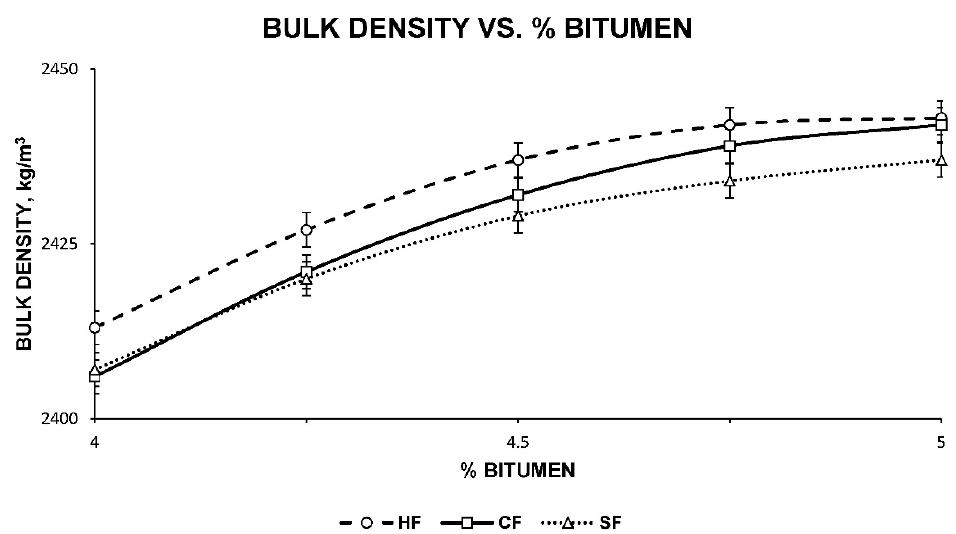
Figure 5. Bulk density of the HF, CF and SF families of bituminous mixtures according to the percentage of bitumen.